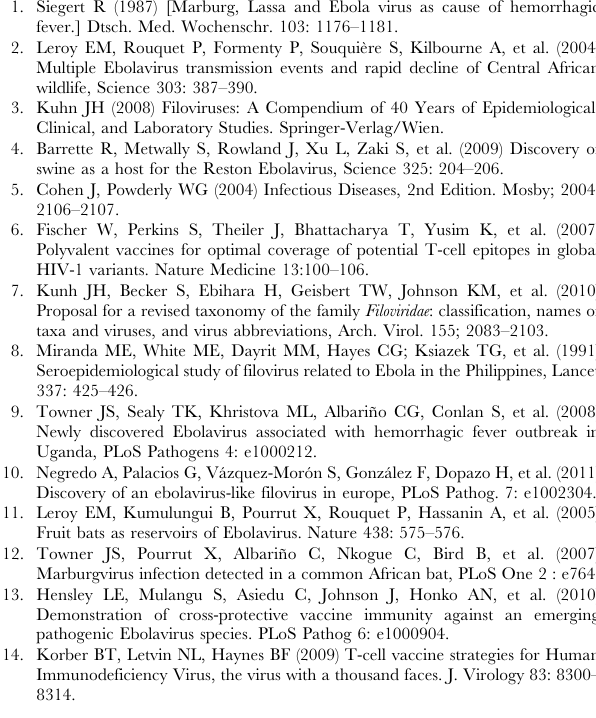
Figure S1 Comparative Protein Phylogeny. Unrooted maximum-likelihood protein phylogenies for Gag and Env protein (HIV-1 M-group) and NP and GP (filoviruses). HIV-1 clades and filoviral speices are indicated by the labels. All trees are drawn to the same scale to facilitate comparison of the phylogenetic diversity of HIV-1 and the filoviruses. All trees were made using the same tree-building methodology. All alignments used to make these trees were gap-stripped. HIV-1 M-group alignments are the reference alignments from the Los Alamos HIV Database (hiv.lanl.gov). Filovirus alignments were made using muscle to align the new filovirus protein set. Protein maximum-likelihood phylogenies were made using FastTree with default